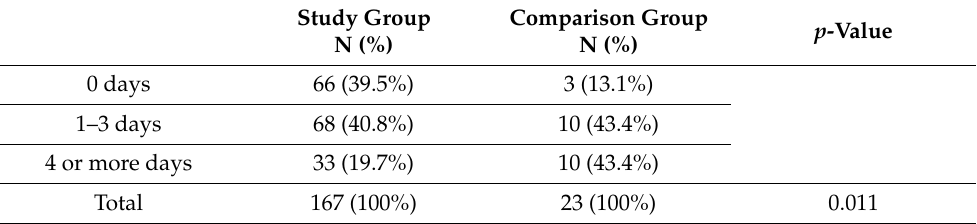
Table 6. Frequency of days working with